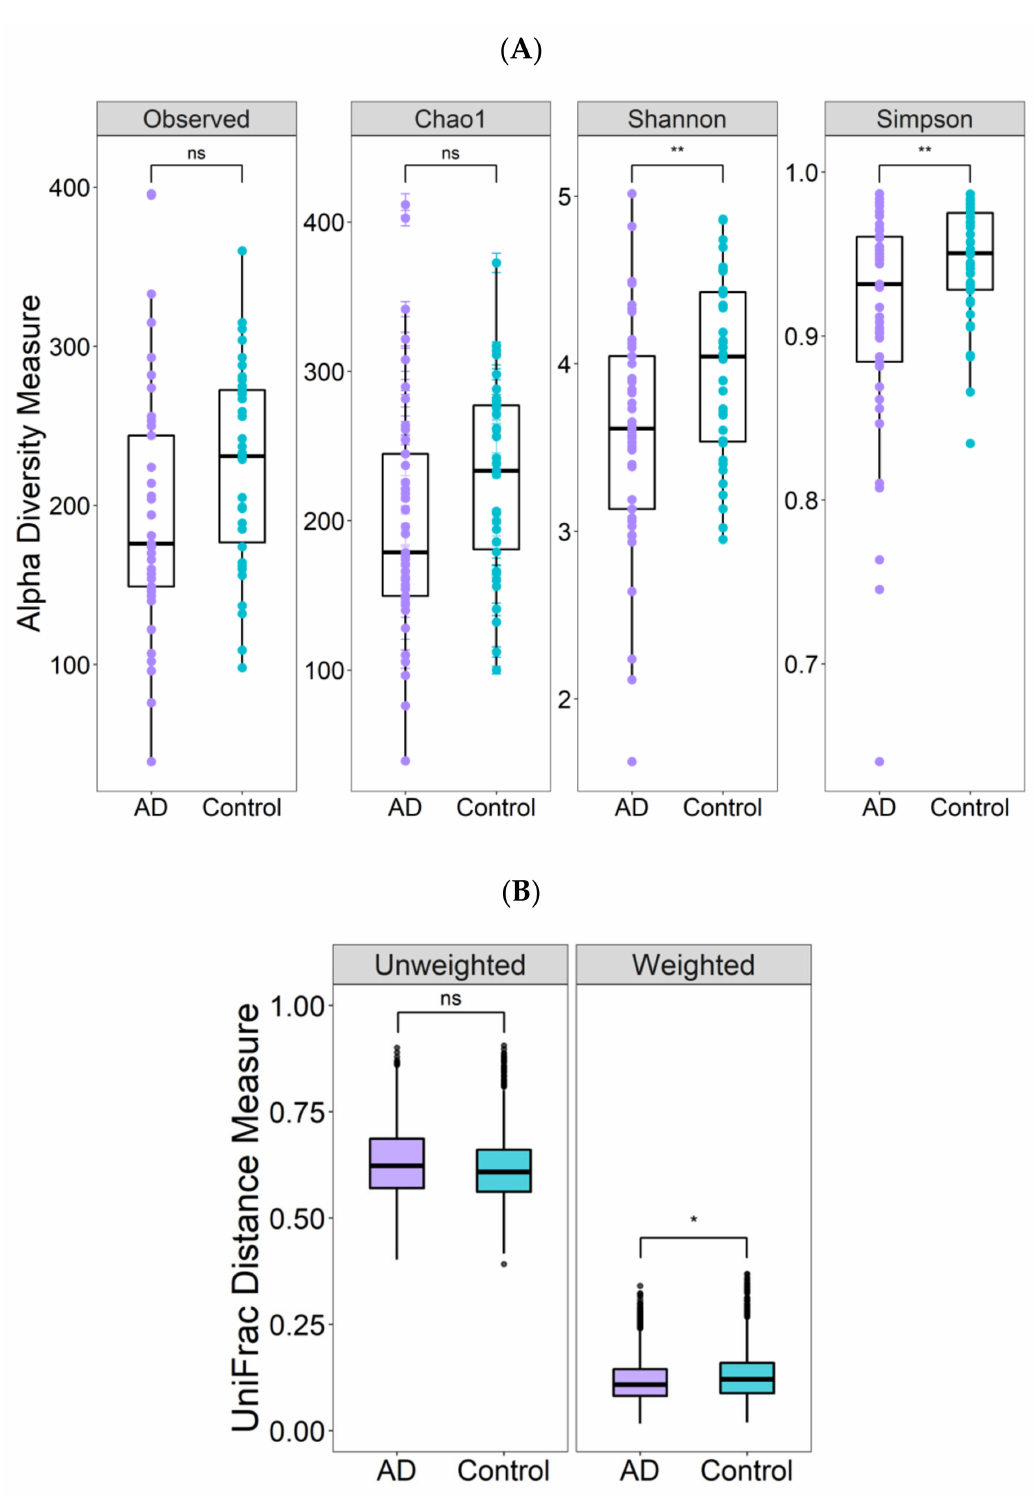
Figure 2. Comparison of gut microbiota diversity in atherogenic dyslipidemia (AD) patients and controls. ( A ) Alpha diversity estimates: Observed OTUs, Chao1, Shannon and Simpson indices; the plotted data represent medians and interquartile ranges. ( B ) Beta diversity estimates; the plotted data represent the weighted (F-value= 2.298; R-value= 0.0289) and unweighted (F-value= 1.299; R-value= 0.017) UniFrac distances; p -value was obtained using a permutational multivariate analysis of variance (PERMANOVA). * p < 0.05; ** p < 005; ns, not